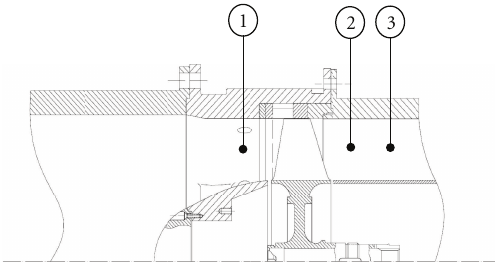
Figure 3: Cross-section view of the test section [22]. Table 5: Design features of the CBUAA [22].